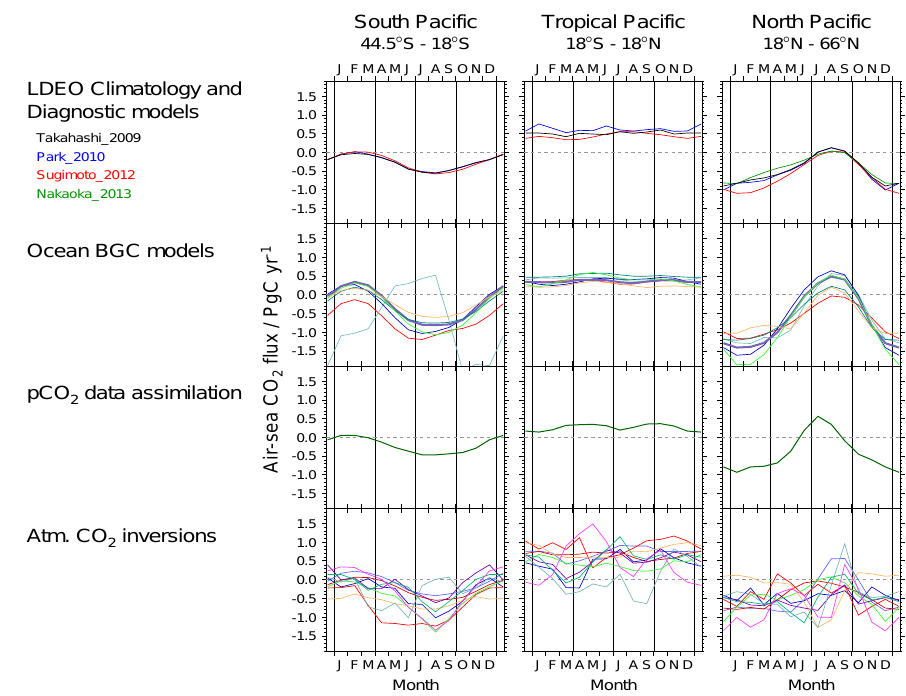
Fig. 9. Mean monthly variations of air–sea CO 2 flux in the South Pacific extratropics (44.5–18 ◦ S) (left), in the tropical Pacific (18 ◦ S–18 ◦ N) (middle) and in the North Pacific extratropics (18–66 ◦ N) (right) for